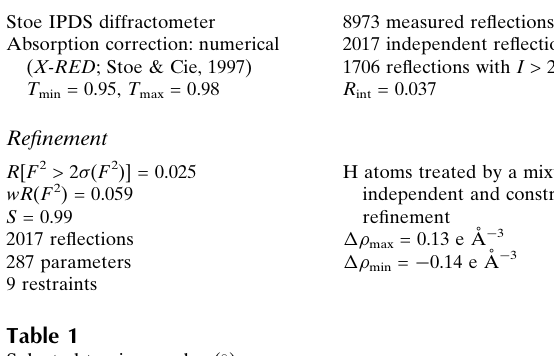
Selected torsion angles ( (cid:3) ).